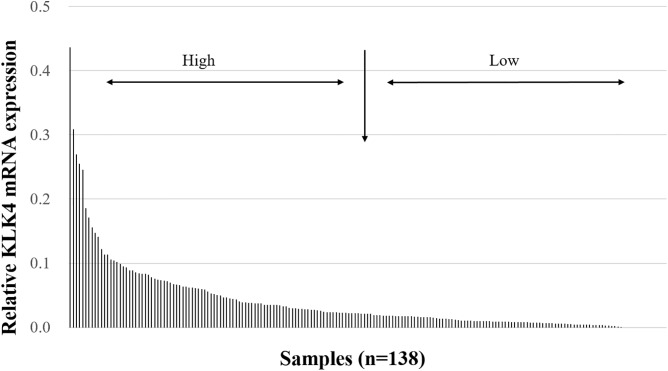
KLK4 mRNA expression levels in tumor tissues of patients afflicted with advanced high-grade serous ovarian cancer (FIGO III/IV).The cumulative histogram depicts relative KLK4 mRNA expression levels (normalized to HPRT mRNA levels). Most samples display very low expression. For further analysis, we categorized the KLK4 mRNA expression levels into low expression versus high expression groups by the 50th percentile (median).